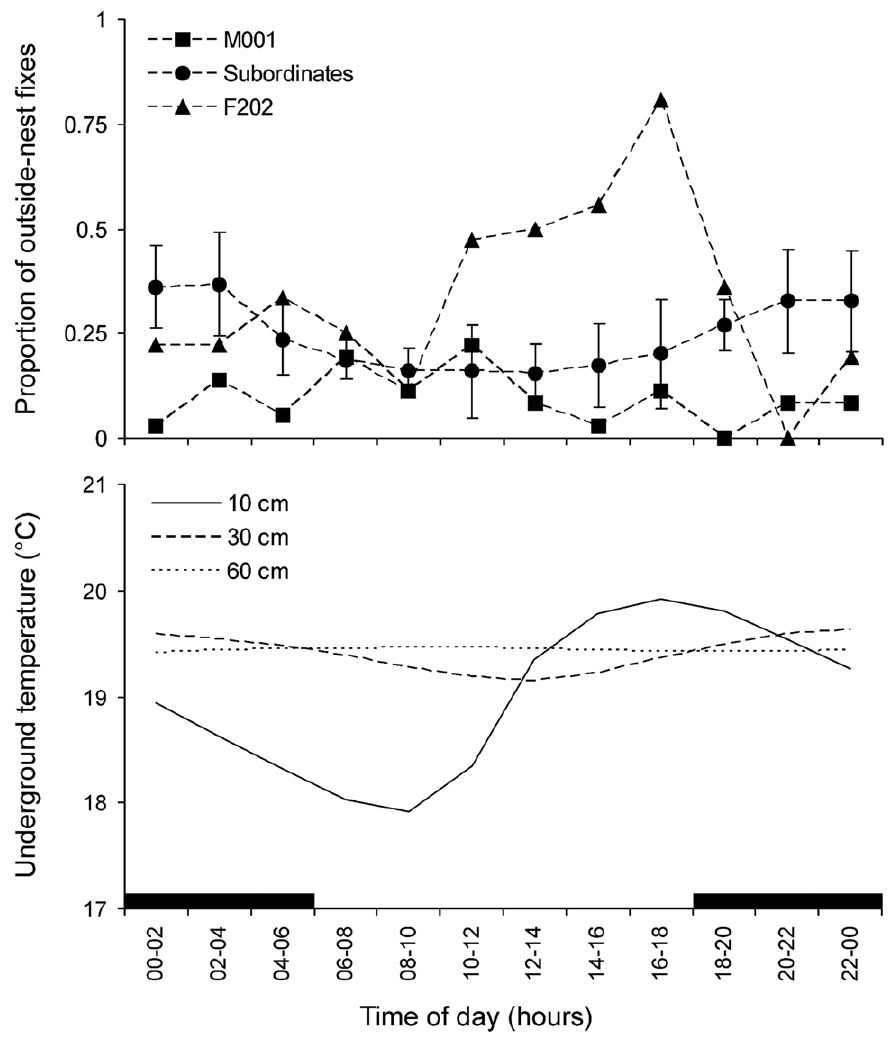
Figure 4. Activity of radio-tracked mole-rats and associated environmental conditions during the 24-h day. Mean 6 SD is presented for the four subordinate (non-breeding) family members. Black bars indicate the dark phase of the day.